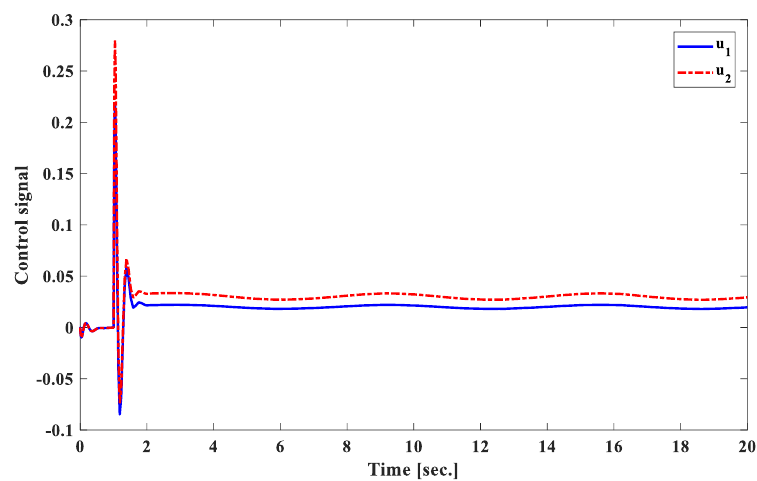
Figure 13. Tie-line power [p.u.MW] of control areas 1 and area 2 under mismatched disturbances.